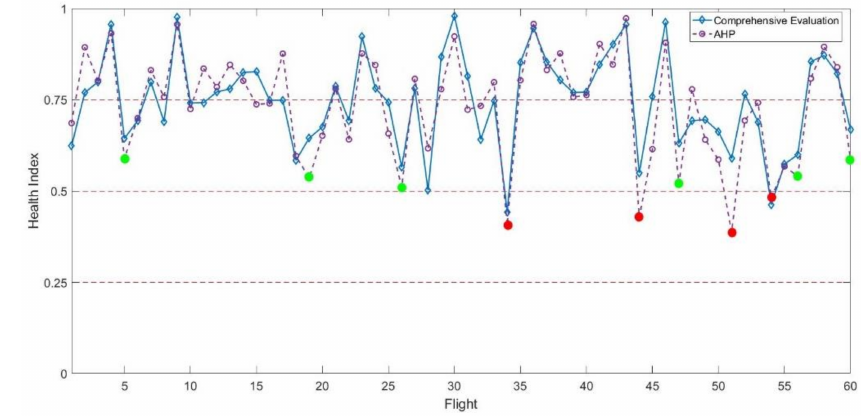
Figure 9. Comparison of Analytic Hierarchy Process (AHP) and comprehensive